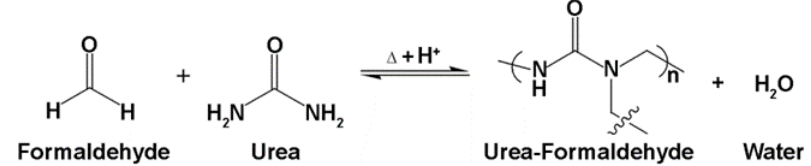
Figure 1. The reversible reaction of urea and formaldehyde for providing the urea–formaldehyde polymer that can be hydrolyzed to liberate formaldehyde.